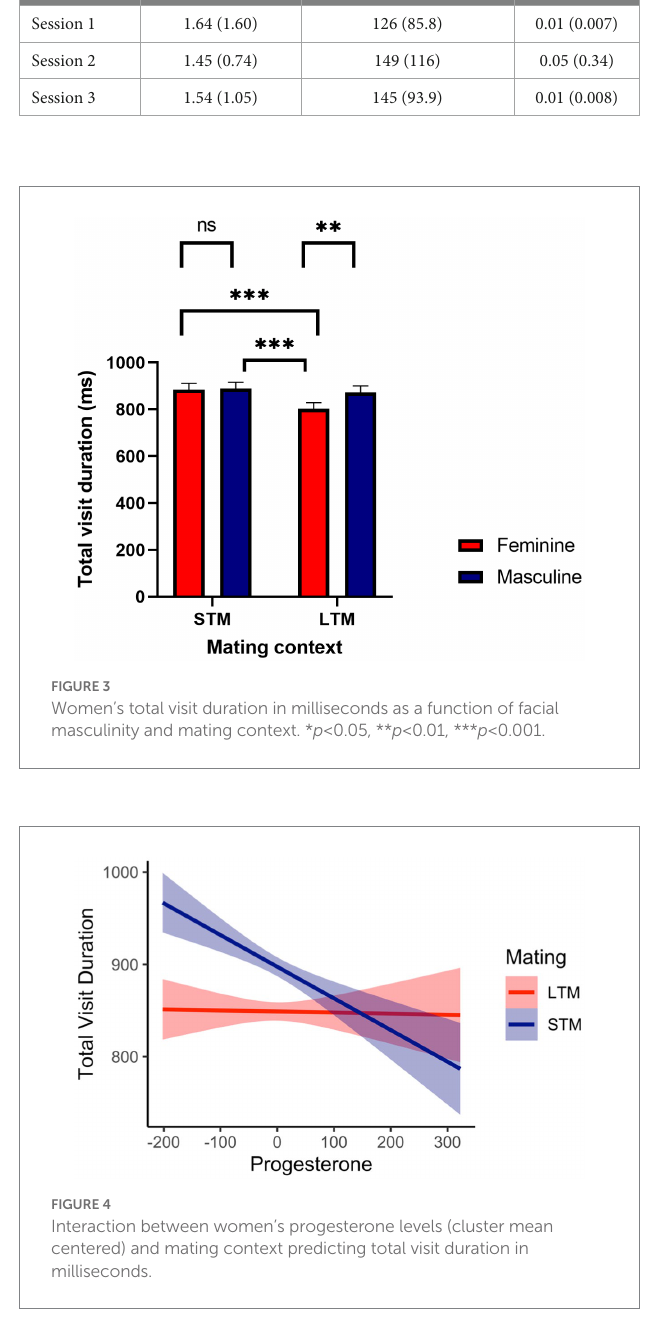
TABLE 1 Raw hormone levels for estradiol, progesterone, and E/P ratio across the three sessions.